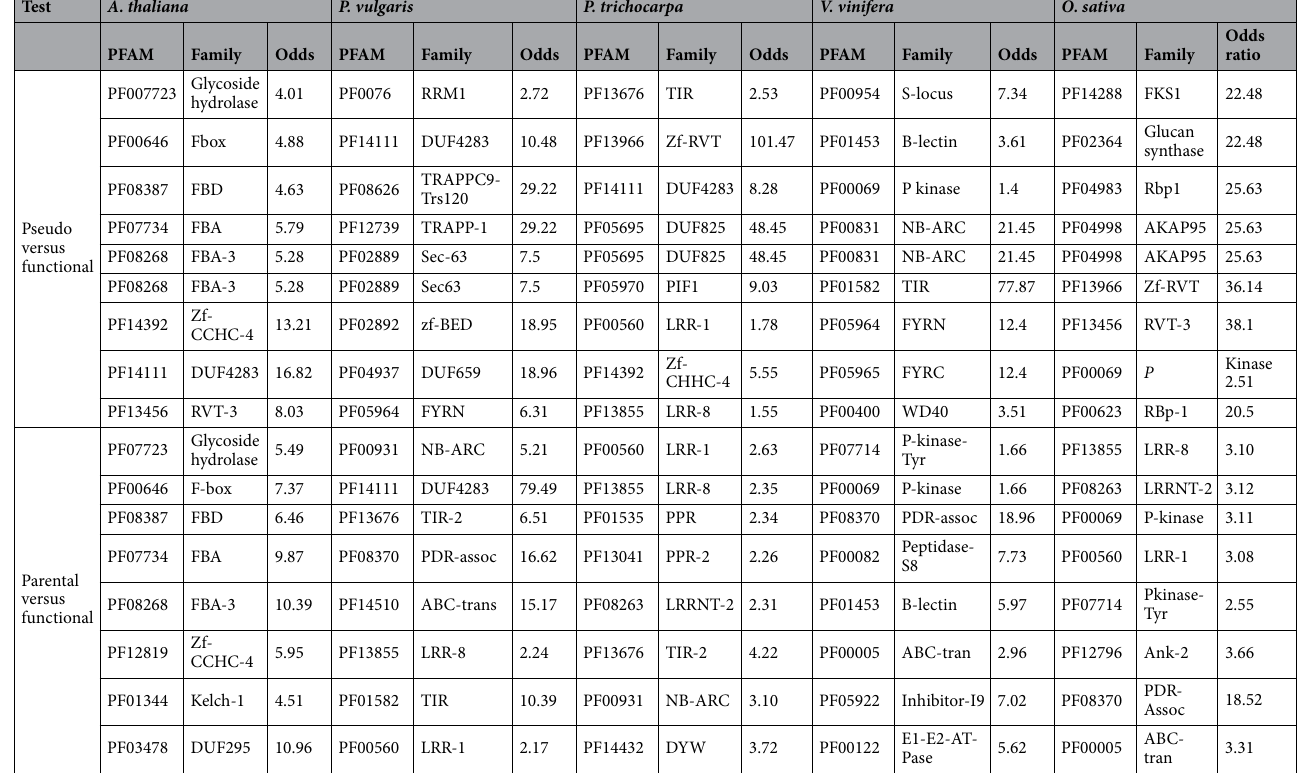
Table 1. Enrichment tests of pseudogene and pseudogene parental locus PFAM domains with respect to PFAM domains of functional loci used as queries across the five plant genomes. Fisher tests: